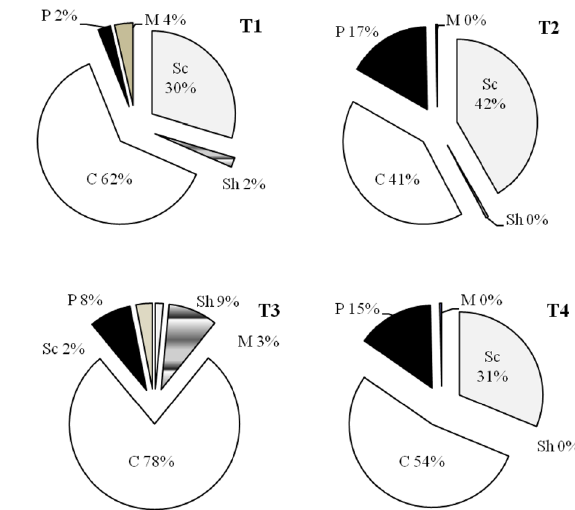
Figure 3. Percentage composition of functional feeding groups at various stations in the Tons River. C - Collector; M - Miscellaneous; P - Predator; Sh - Shredder; Sc -